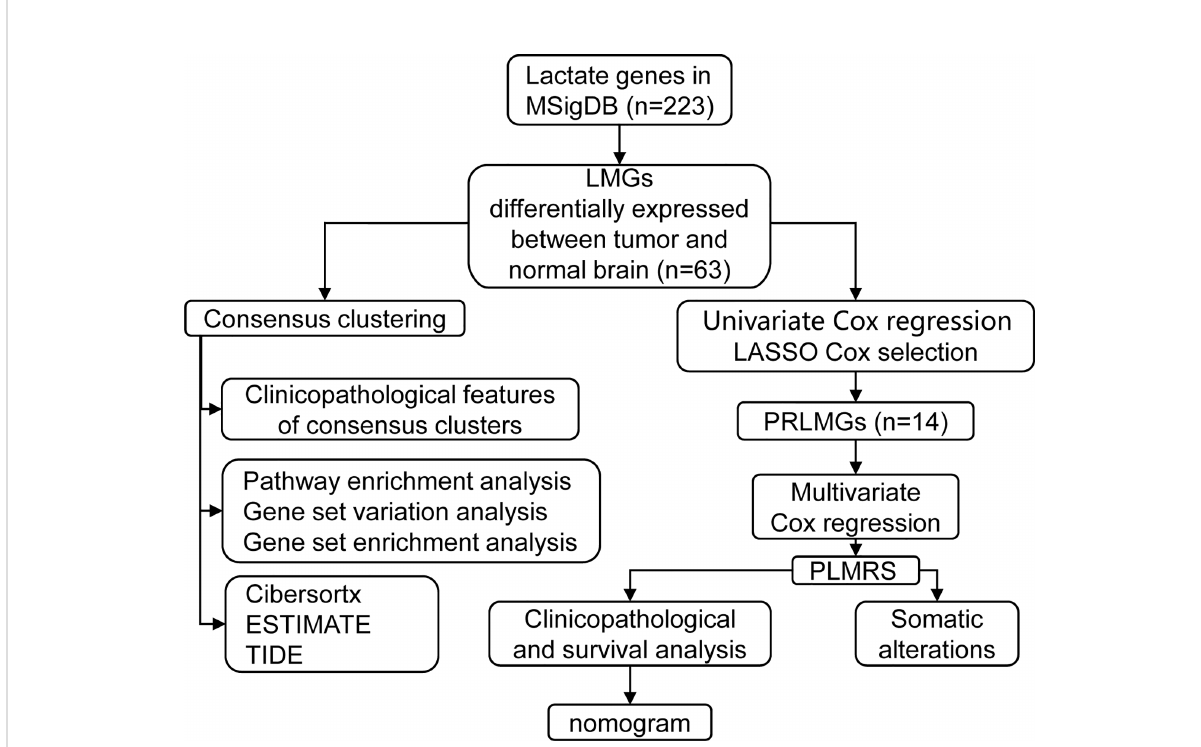
FIGURE 1 Flow chart of study design. MSigDB, Molecular Signature Database; DEG, differentially expressed gene; LMG, lactate metabolism-related gene; ESTIMATE, Estimation of STromal and Immune cells in MAlignant Tumor tissues using Expression data; TIDE, Tumor Immune Dysfunction and Exclusion; LASSO, Least Absolute Shrinkage and Selection Operator; PRLMG, prognosis-related lactate metabolism gene; PLMRS, prognostic lactate metabolism risk